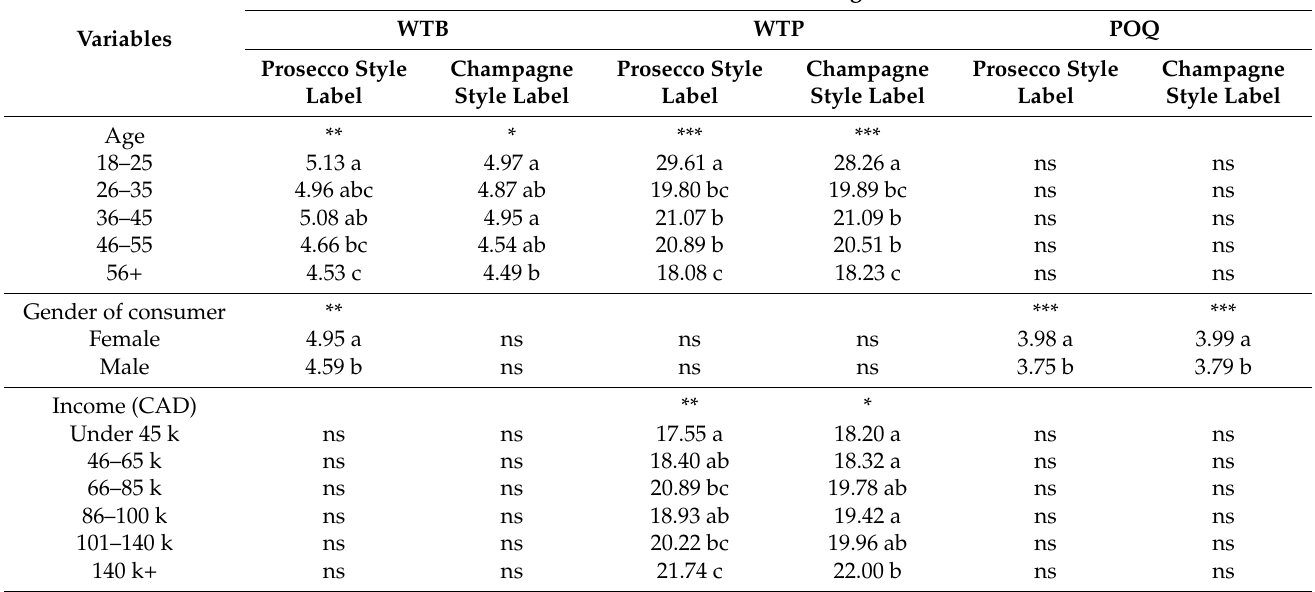
Table A3. Mean values for significant effects on willingness to buy (WTB) (7-point Likert